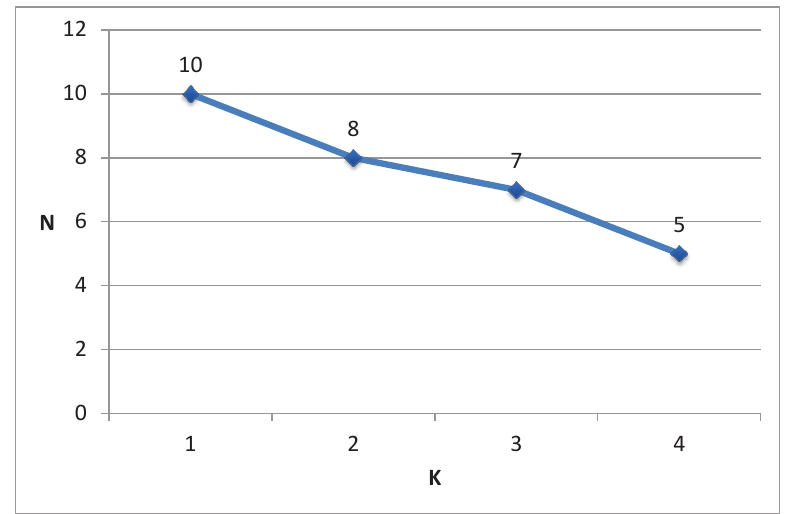
Fig. 1. Dynamic of students-volleyball-players’ traumatism for four years of Table 1. Characteristic of volleyball players’ traumas by the character of damages (quantity)